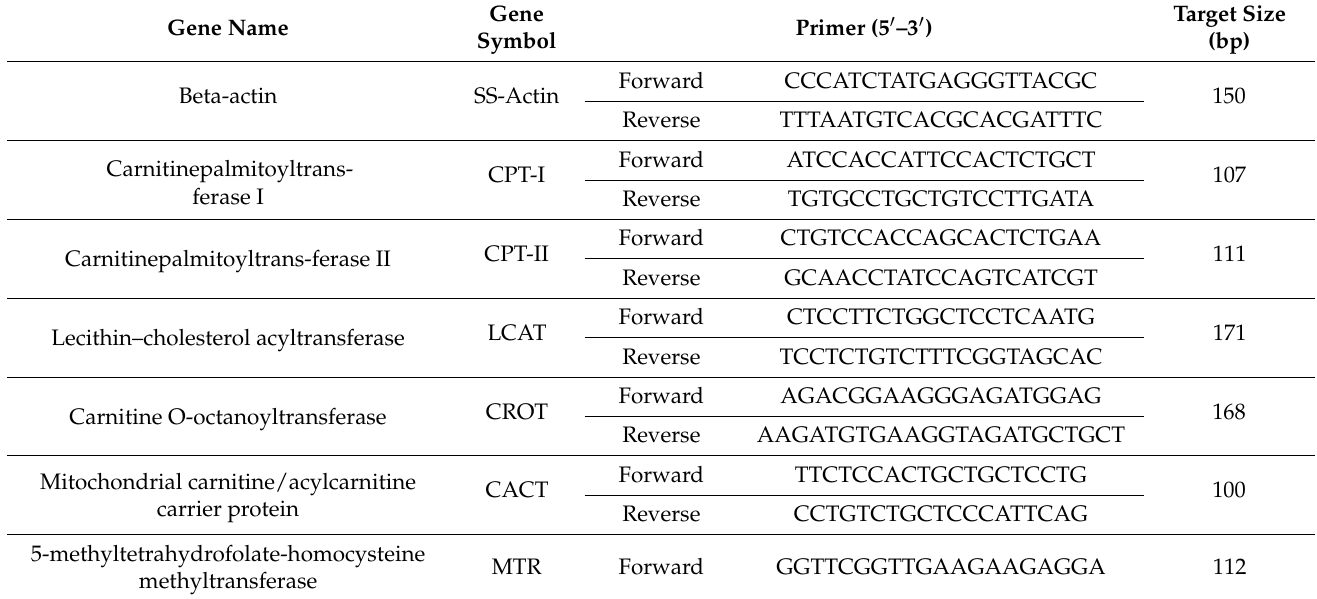
Table 1. List of the primers employed in the qRT-PCR analysis of the targeted